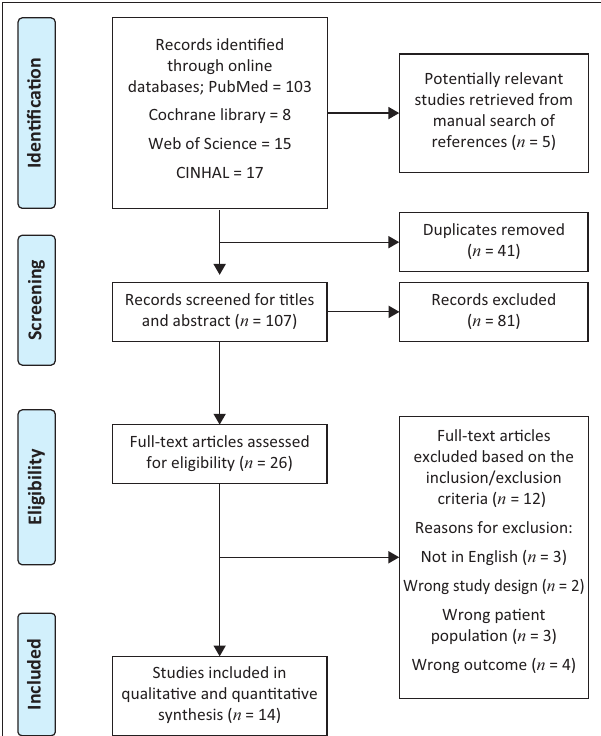
FIGURE 1: Characteristics of included